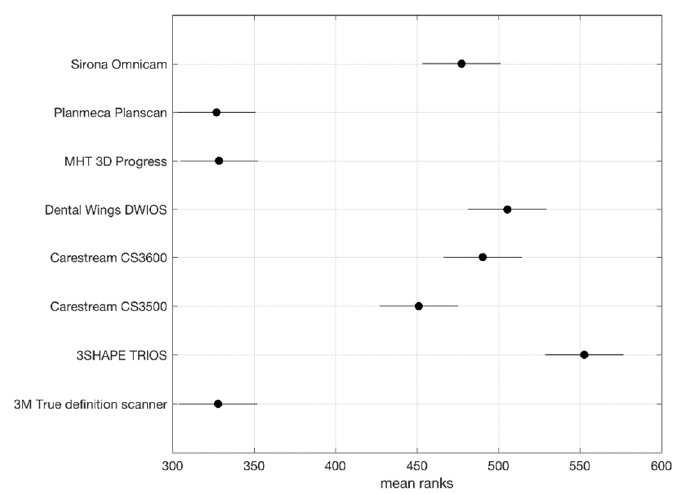
Figure 7. The Kruskal-Wallis tests revealed a statistically significant difference ( p -Value < 0.5) in the mean marginal gaps between copings produced by different I.O.S.s.